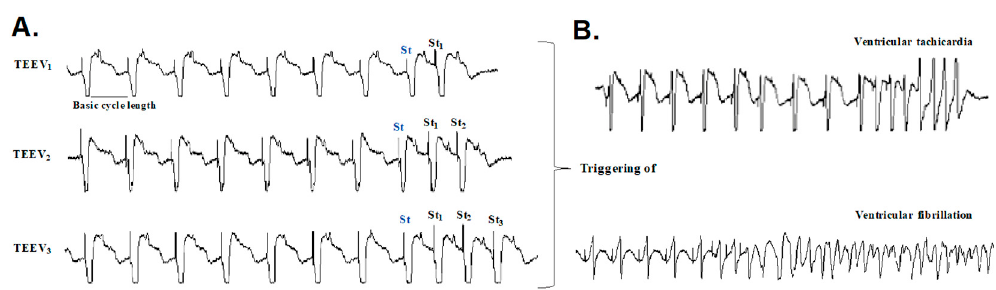
Figure 3. ( A ): An example of the ventricular extrastimulus testing (VEST) applied with up to three extrastimuli (St 1 , St 2 , and St 3 ), with St being the last stimulus of the basic series. ( B ): VEST induction of an episode of a self-limiting ventricular tachycardia and a ventricular fibrillation.